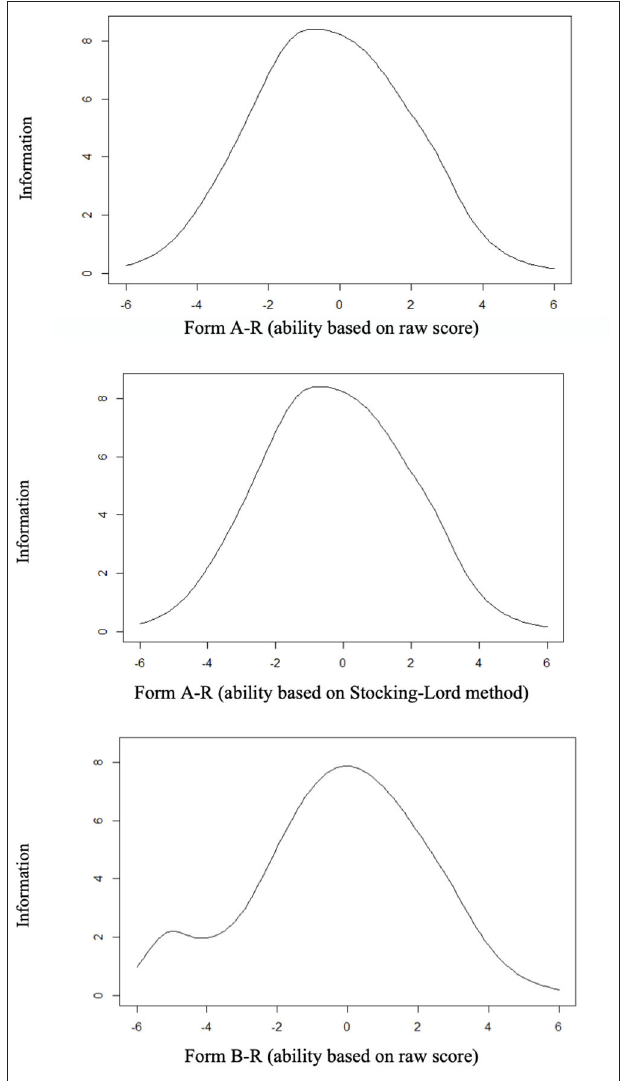
FIGURE 2 | Test information for Form A-R (upper graphics) and Form B-R (lowest graphic).